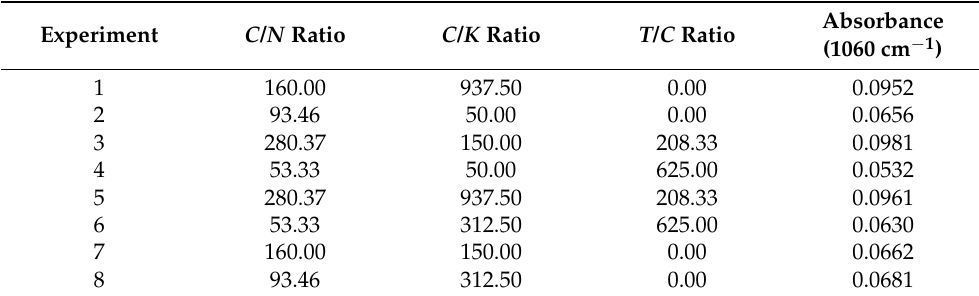
Table 6. Fermentation data. Independent variables: C/N and C/K ratios; dependent variable: ab- sorbance at 1060 cm − 1